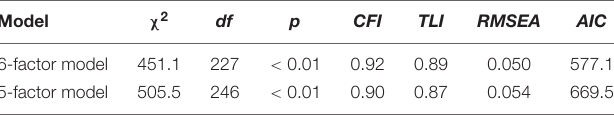
TABLE 6 | Model fits of the 5-factor and 6-factor models (Study